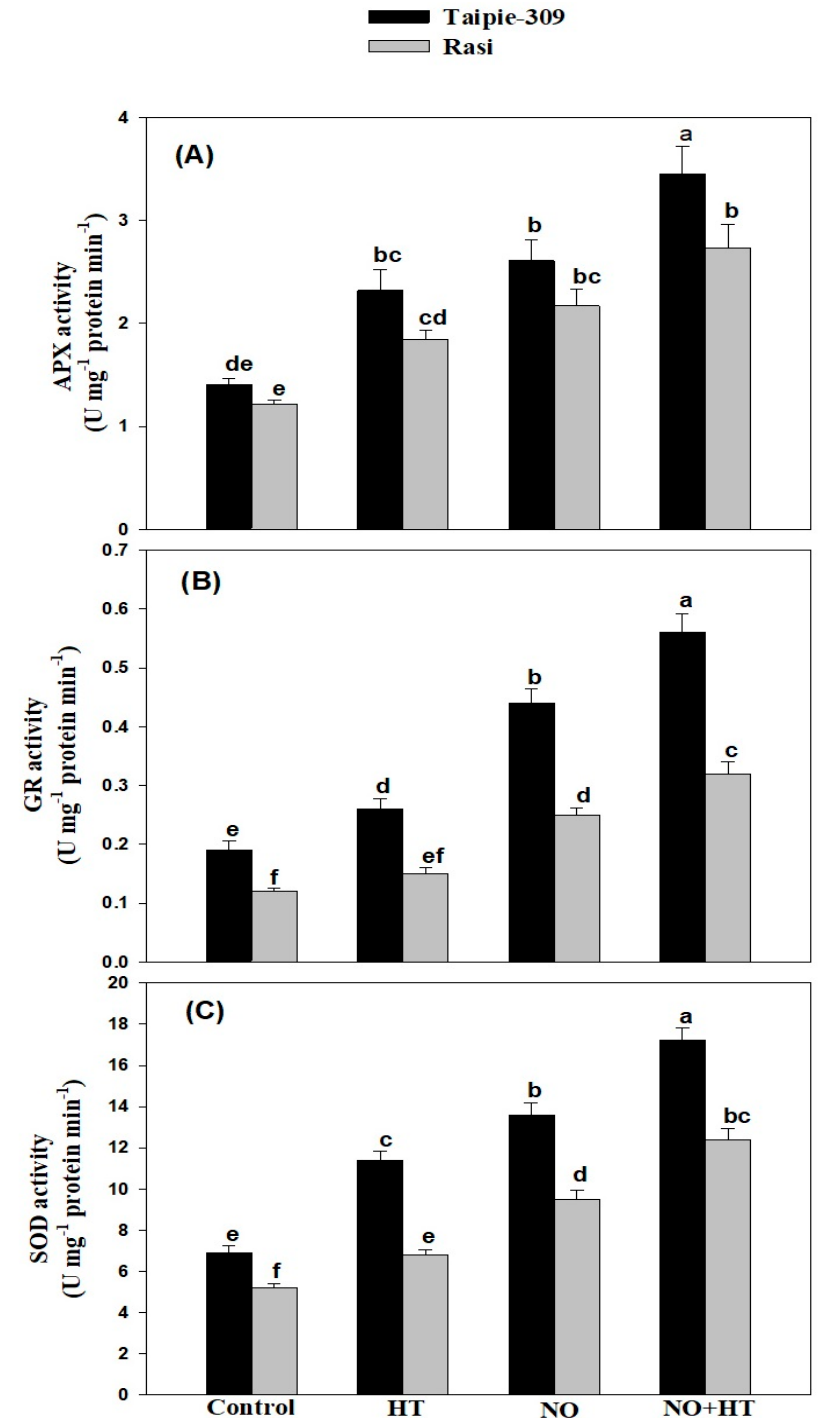
Figure 2. Ascorbate peroxidase (APX, A ), glutathione reductase (GR, B ), and superoxide dismutase (SOD, C ) activities in Taipie-309 and Rasi cultivars of rice ( Oryza sativa L.) at 30 days after germination (DAG), plants were grown with/without high temperature stress and treated with foliar 100 µ M SNP (NO donor). Data are presented as treatments mean ± SE (n = 4). The values followed by same letters above bars represent that data did not differ significantly by LSD test at p < 0.05.